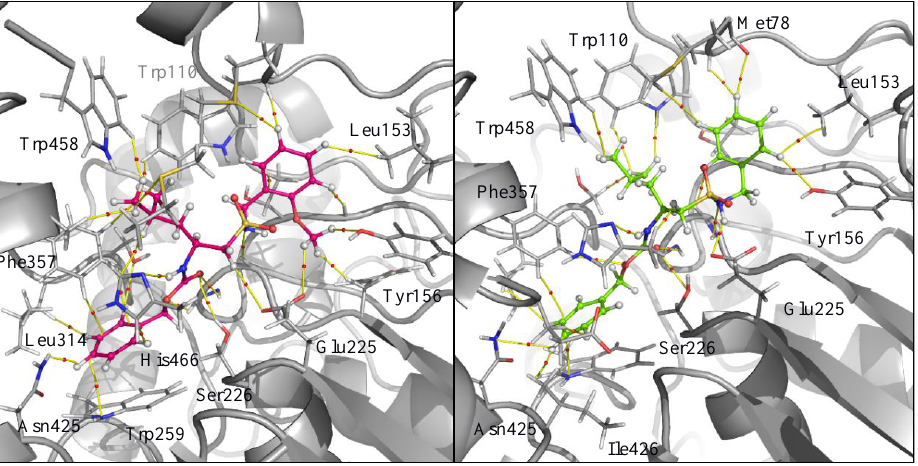
Figure 9. Charge density molecular graph of compounds 5c (A, pink) and 5k (B, green) at the gorge of BChE. Residues from active site are shown in grey. Topological elements of charge density associated with intermolecular interactions are depicted with yellow lines (bond paths) and small red spheres (bond critical points).